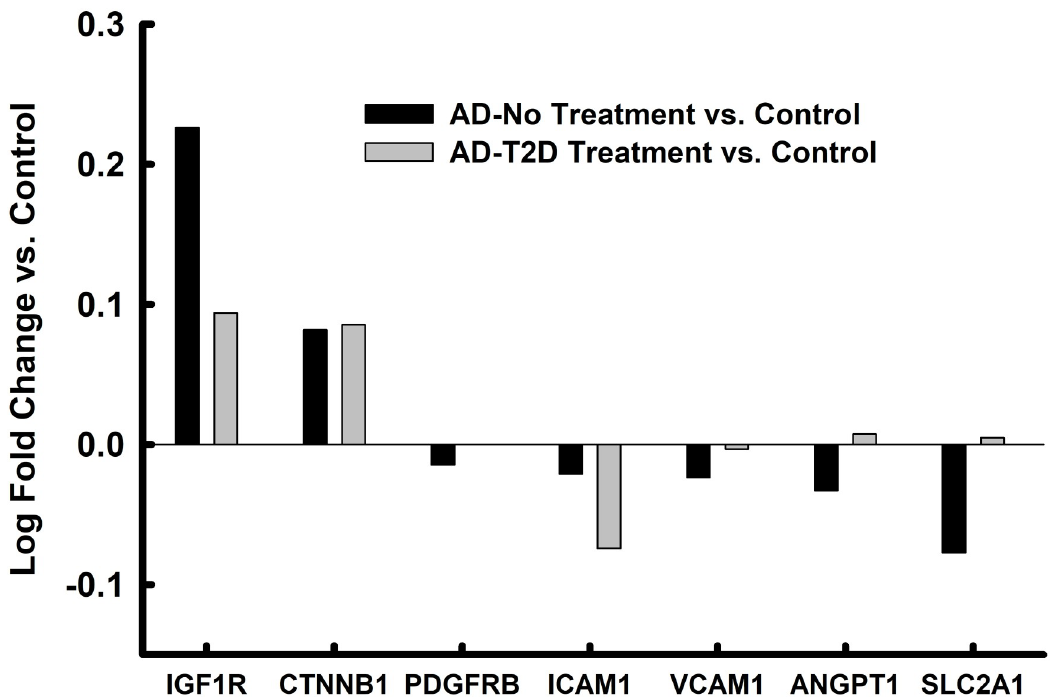
Fig 4. Endothelial cell markers in microvascular enriched isolates from the parahippocampal gyrus. Values represent relative log fold change in persons with AD relative to controls and log fold change in persons with AD and T2D who had been treated with anti-diabetes agents. � = p < 0.05 after FDR correction; # = p < 0.05 without FDR correction; ✦ = p < 0.05 AD-No Treatment vs. AD-T2D Treatment.